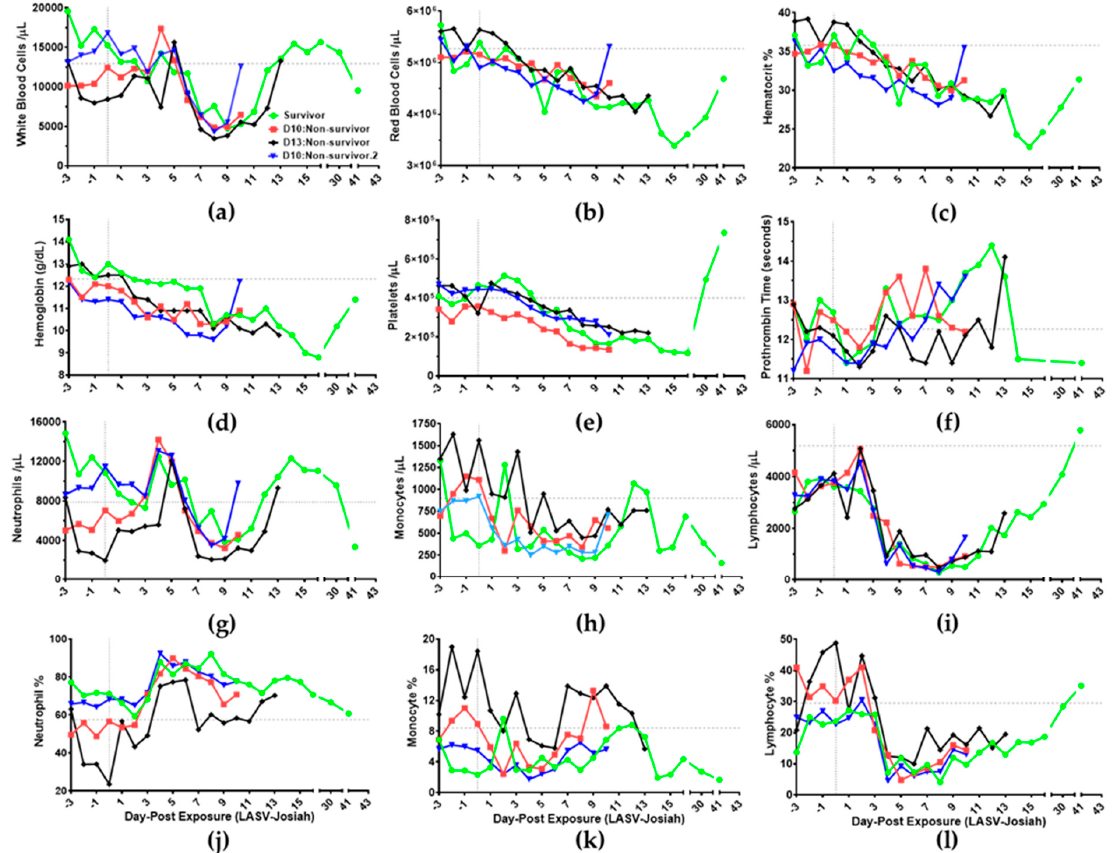
Figure 6. Time course analysis of blood cells and circulatory components from aerosol LASV-infected cynomolgus macaques. ( a ) Number of white blood cells, ( b ) number of red blood cells, ( c ) hematocrit percentage, ( d ) amount of hemoglobin ( e ) number of platelets, ( f ) prothrombin time, ( g ) number of neutrophils, ( h ) number of monocytes ( i ) number of lymphocytes, ( j ) percentage of neutrophils, ( k ) percentage of monocytes, and ( l ) percentage of lymphocytes detected per microliter of blood by Hemavet 950FS hematology analyzer. Prothrombin time ( f ) was detected using iStat1 PT/INR. ( ● Survivor) ( ■ D10:Non-survivor) ( ♦ D13:Non-survivor) ( ▼ D10:Non-survivor.2) (Vertical grey dotted line: DPE 0) Grey dashed line is average relative to each animal for DPE -3 to DPE 0.